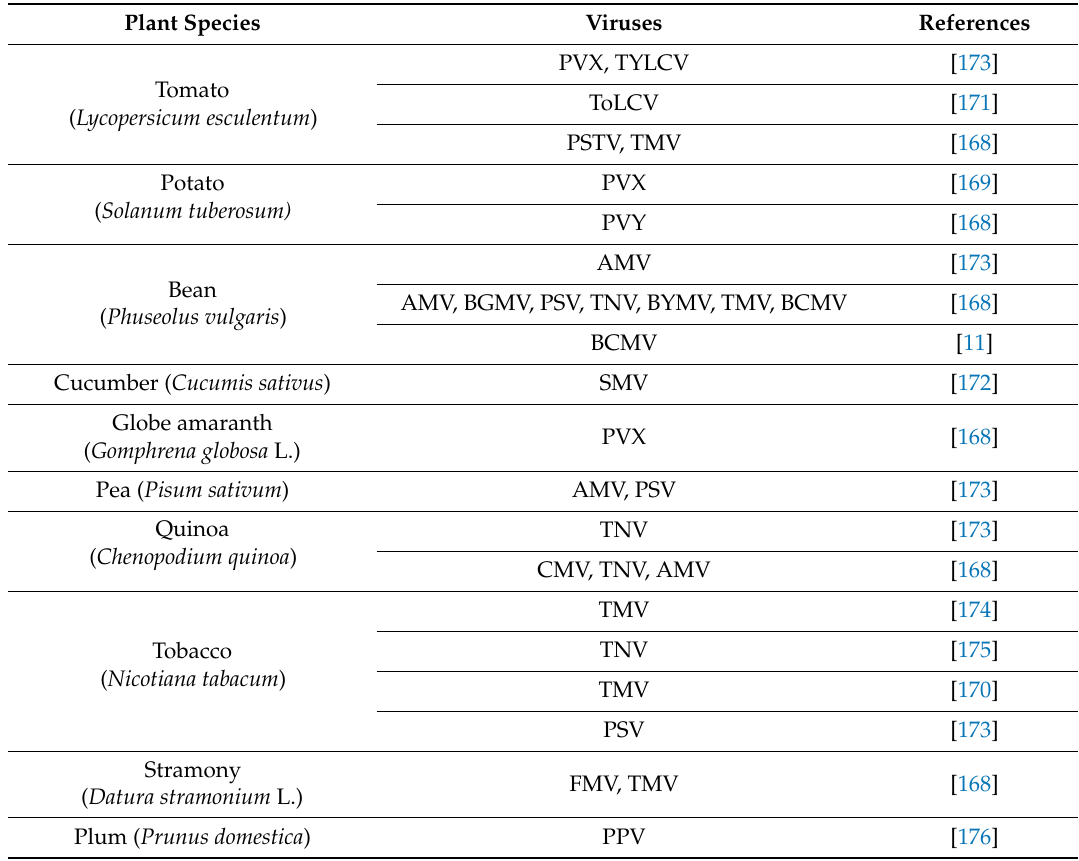
Table 4. In vivo antiviral activities of